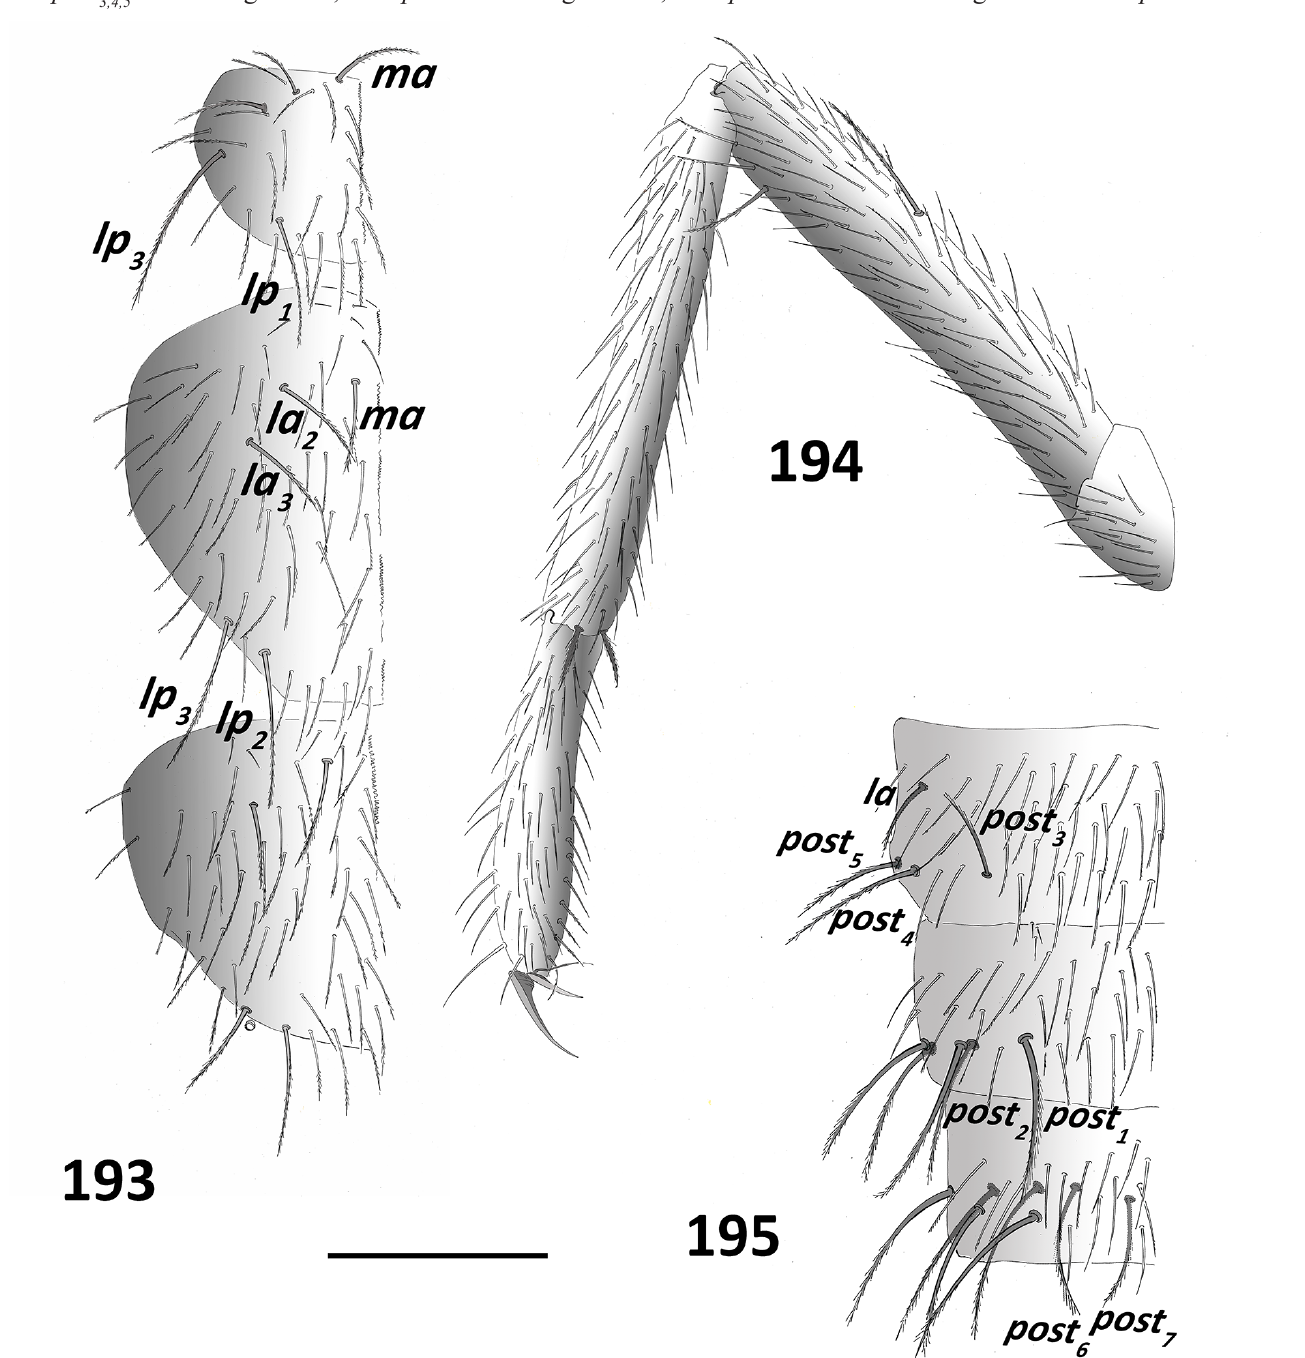
Figs 193–195. Plusiocampa ( Venetocampa ) ferrani Sendra & Delić sp. nov., holotype, ♂, from Ferranova buža, Vrhnika, Slovenia (MZB 2019-1031). 193 . Pronotum, mesonotum and metanotum, left side. 194 . Metathoracic leg. 195 . Urotergites VII–VIII and abdominal segment IX, right side. Scale bar: 0.2